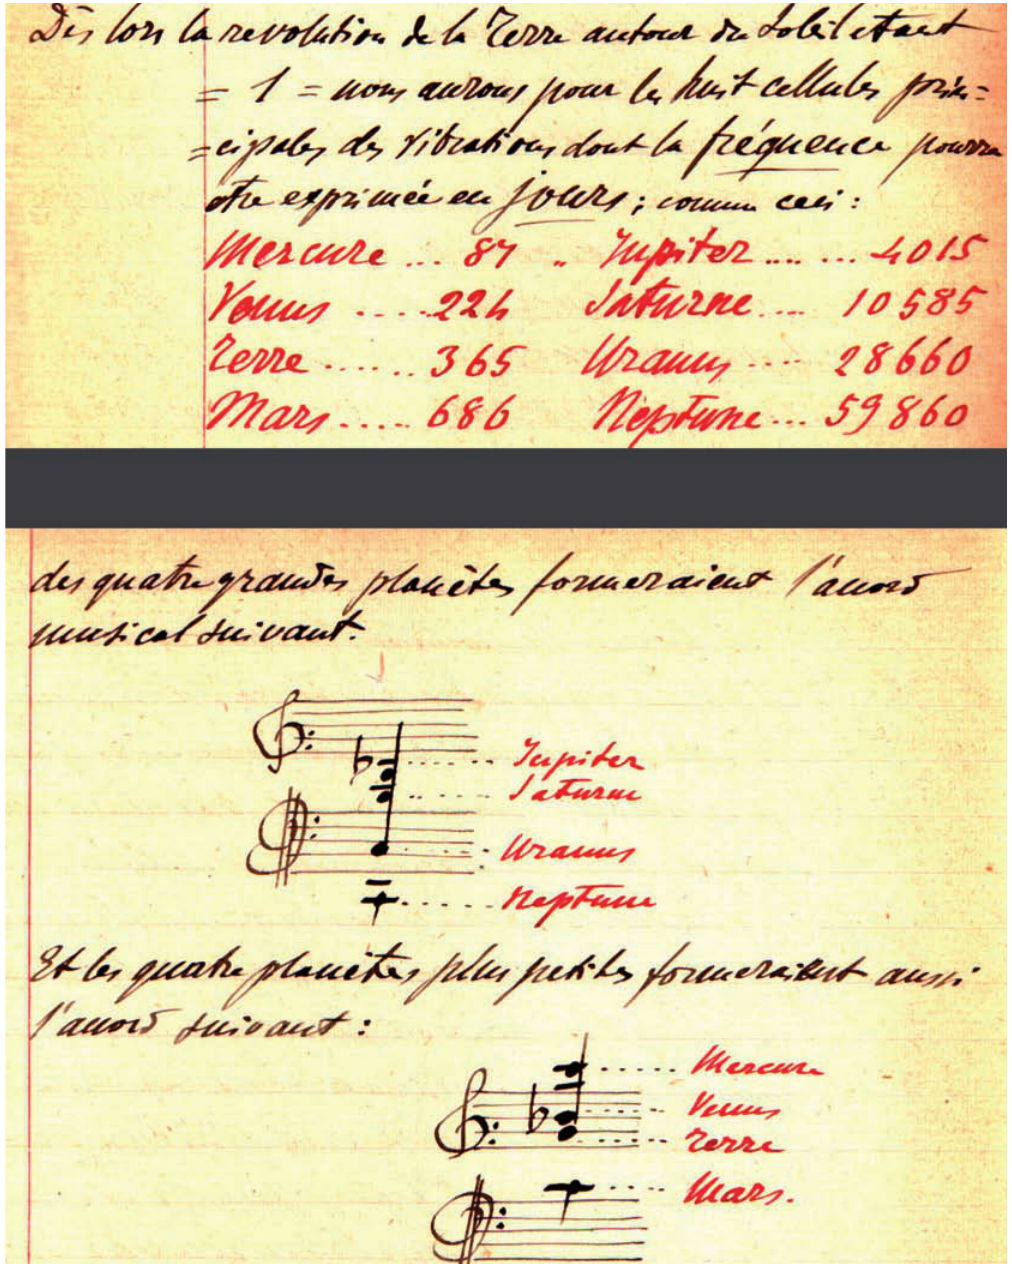
Fig. 10. Two pages of the manuscript Radiation Universelle from 1912, in which Mantovani lists the periods of revolution of the planets considering them as periods of vibration. Then he scales the periods to the musical pentagram, writing two distinct accords, the first for the external planets and the second for the internal